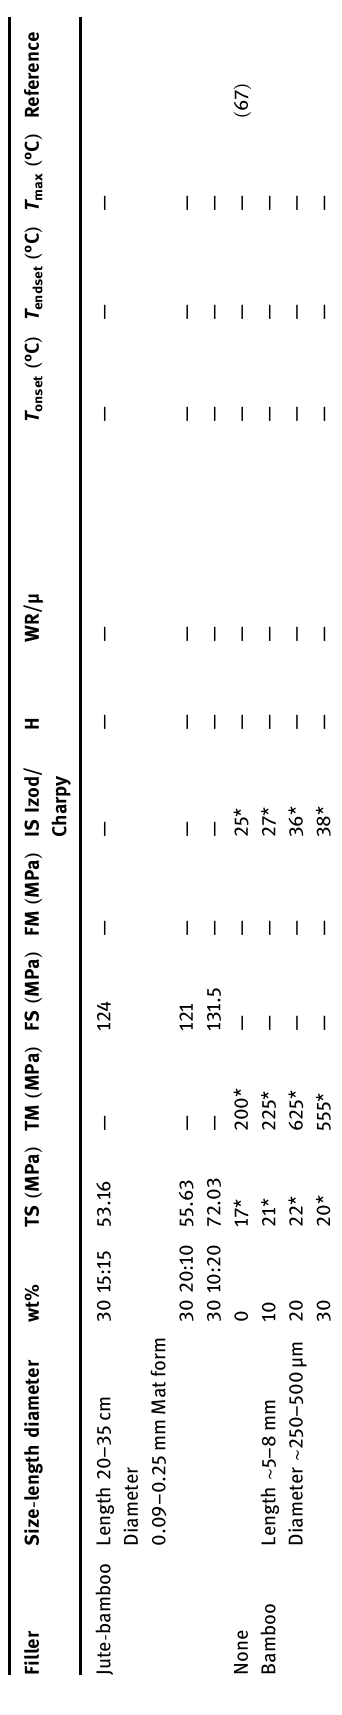
mixing technique. The unsaturated resin was mixed with hardener. Then, the mixtures were cured for 24 h at room temperature. The presence of wheat straw in polye - ster resin has improved marginally the tensile properties, and T as pre - while it has not a ff ected both T onset endset sented in Table 4. In addition, four wt% ( 5, 10, 15, and 20 ) of chopped and mat Rambans fi ber ( agave ) with balanced wt% ( 2 wt% ) of hardener ( methyl ethyl ketone peroxide ) and 2 wt% accelerator ( cobalt ) were added to polyester resin. The composites were subjected to the compression molding process at a constant load after the curing process had started. The Vickers H property in addition to the strength of tensile, fl exural, and notched Charpy impact was char - acterized by Prasad et al. ( 60 ) . All these characteristics have been improved except for the WR where it has wor - sened. Coupling 15% of agave fi ber with polyester has culminated the TS, FS, and IS as it is displayed in Table 4. H property has reached the climax at 5 wt% of the fi ber with the improvement of 50%. When comparing chopped agave with mat agave at the same weight percentage, it is worthwhile to note that chopped agave has often pro - duced better outcomes. On top of that, Prasad et al. ( 61 ) studied the e ff ects of reinforcing two forms ( chopped fi bers and matted fi bers ) of diverse types of fi bers ( HE, nettle and hemp - nettle ) at di ff erent wt% ( 3, 6, and 9 wt% ) on speci fi c WR, Charpy impact, H Vickers, FS, and TS. The composites were prepared by the manual layout process. Table 4 presents that the FS and IS of chopped HE and chopped nettle have been enhanced along with the increase of wt%. The TS of chopped HE - polyester composite has also been increased, while it has been changed irregularly when the chopped nettle fi bers have been added. The H has been reduced when chopped nettle and chopped HE were introduced to the polyester matrix. The WR of both fi bers has fl uctuated irregularly. With turning to the hybrid fi ller ( mat of HE and nettle ) , it can be noted that most of the properties have fl uctuated slightly. Munshi et al. ( 59 ) assessed fl exural, tensile, H, and impact properties of polyester composites. Besides, thermogravimetric proper - ties were also investigated. The composites were rein - forced by di ff erent fi ber loadings ( 10, 20, and 30 wt% ) of a uniform ratio of rattan and bamboo ratio ( 1:1 ) . The fi bers were in the woven mat form. The Hand lay - up process was used for manufacturing the composites. The ratio of polye - ster to the methyl ethyl ketone peroxide ( MEKP ) as hard - ener was ( 98:2 ) . Table 4 displays that the FS has negatively T a